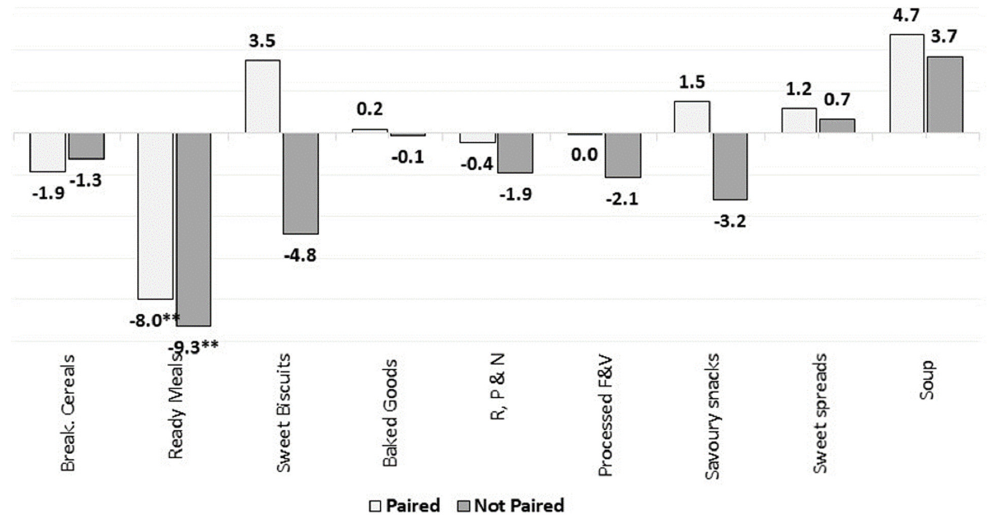
Figure 14. Percentage changes in the market-weighted mean fibre content in paired and unpaired packaged food and soft drinks products in Europe (2015–2018). Source: Elaborated by the authors based on data from Euromonitor (2020). Note: Percentage of products with available information both in 2015 and 2018: 98% for Breakfast Cereals, 88% for Savoury Snacks, Sweet spreads, Soup and Ready Meals, 91% for Baked Goods and Processed Meats, 82% for Processed Fruits, 84% for R, P & N and 83% for Sweet Biscuits. Significance levels: ** 5%.